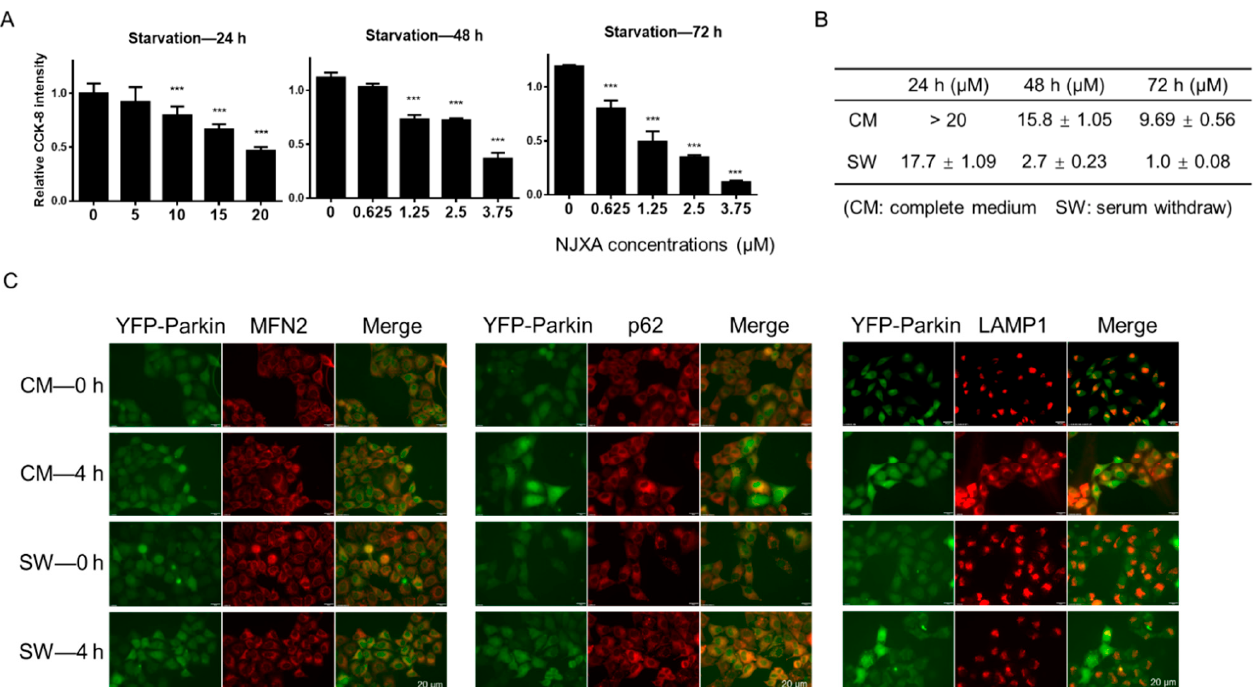
Figure 6. Nutrition deprivation ‐ induced mitophagy enhances sensitivity to NJXA in HeLa cells. ( A ) HeLa cells were treated with NJXA at 0–20 μ M for 24 h and 0–3.75 μ M for 48 and 72 h, respectively, in DMEM without fetal bovine serum. Cells were analyzed by CCK ‐ 8 assay. Data is shown as mean ± SD of three independent experiments, *** p < 0.001. ( B ) The IC 50 values of NJXA were calculated according to the results of the CCK ‐ 8 assay. ( C ) YFP ‐ Parkin HeLa cells were treated with NJXA (5 μ M) for 4 h in DMEM with or without fetal bovine serum. Cells were fixed and stained with MFN2, p62, and LAMP1 antibodies. The images were acquired using a fluorescence microscope. Scale bar = 20 μ m.